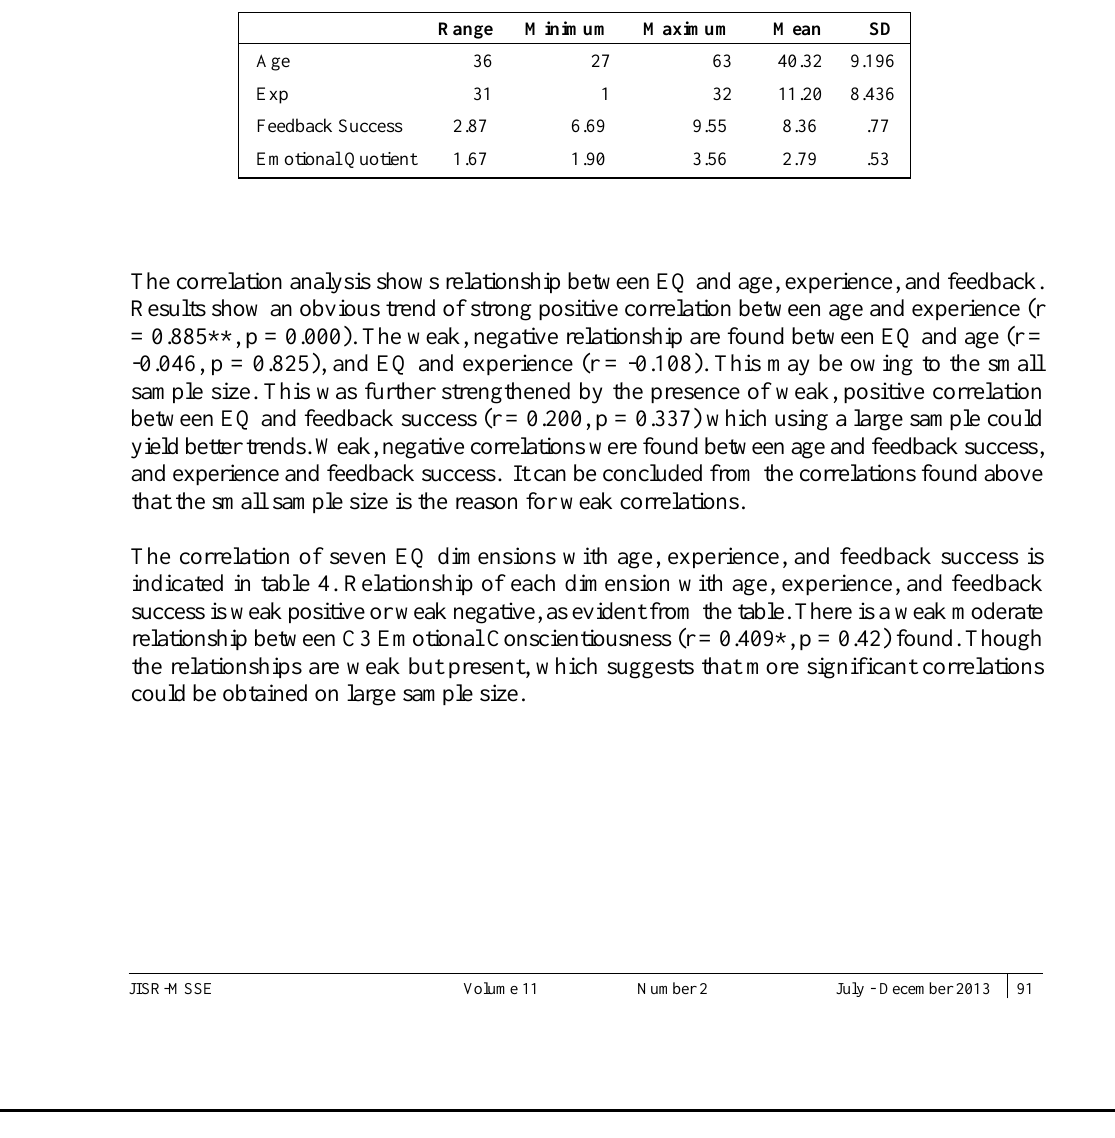
Table 3 Descriptive Statistics of variables (n =